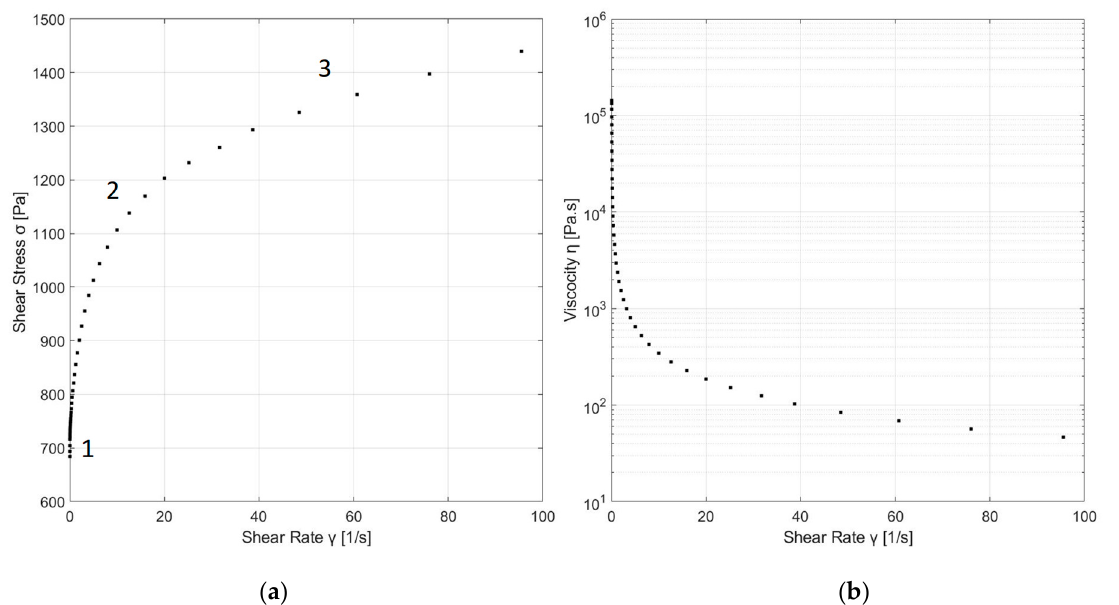
Figure 5. ( a ) Experimental flow curve for hydroxide sludge and ( b ) Apparent viscosity as a function of shear rate.